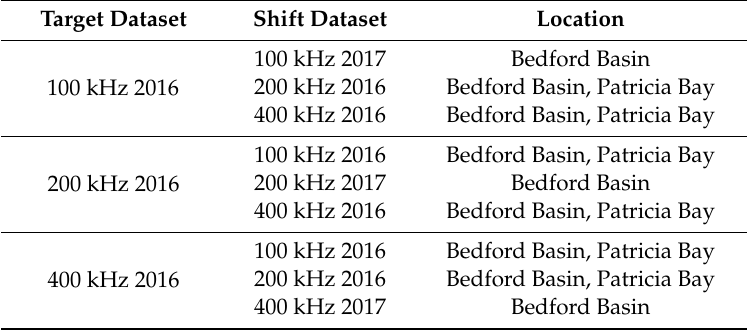
Table 2. Summary of bulk shift simulations.